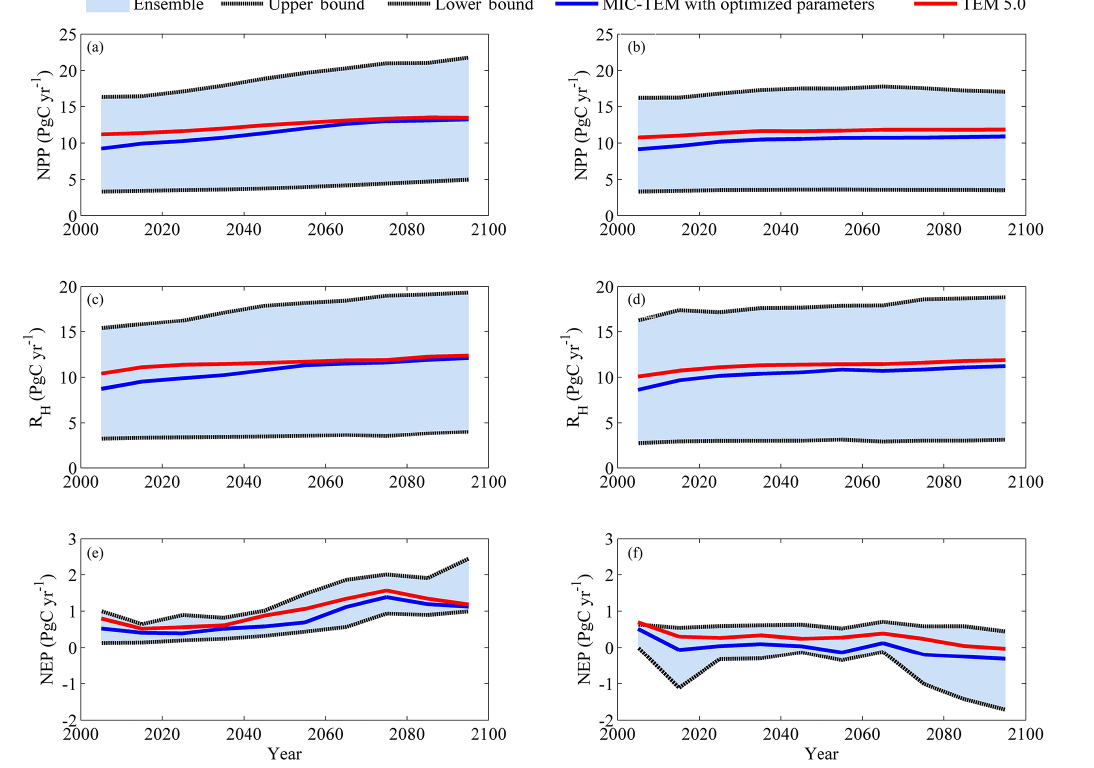
Figure 4. Predicted changes in carbon fluxes: (a, b) NPP, (c, d) R H , and (e, f) NEP for all land areas north of 45 ◦ N in response to transient climate change under (a, c, e) the RCP 8.5 scenario and (b, d, f) the RCP 2.6 scenario with MIC-TEM and TEM 5.0. The decadal running mean is applied. The blue area represents the upper and lower bounds of